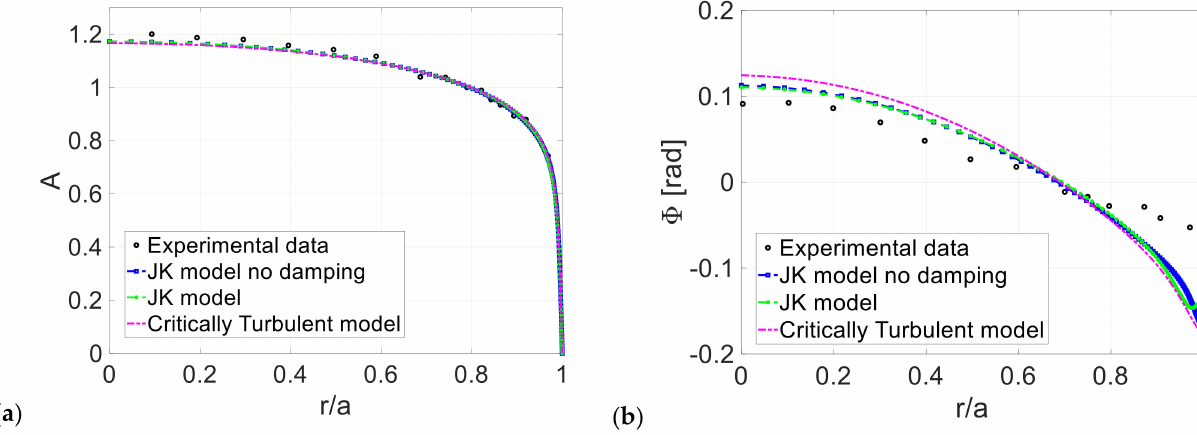
Figure 10. Comparison between experimental data, turbulence models and the critically turbulent assumption (Case 4: Re os = 49,400, α = 23.4): ( a ) amplitude ratio; ( b )